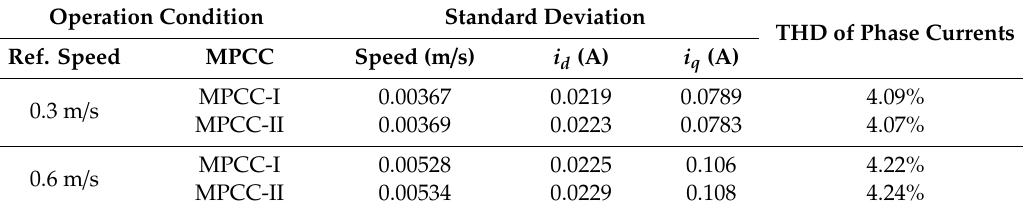
Table 4. Comparison of steady-state performances.